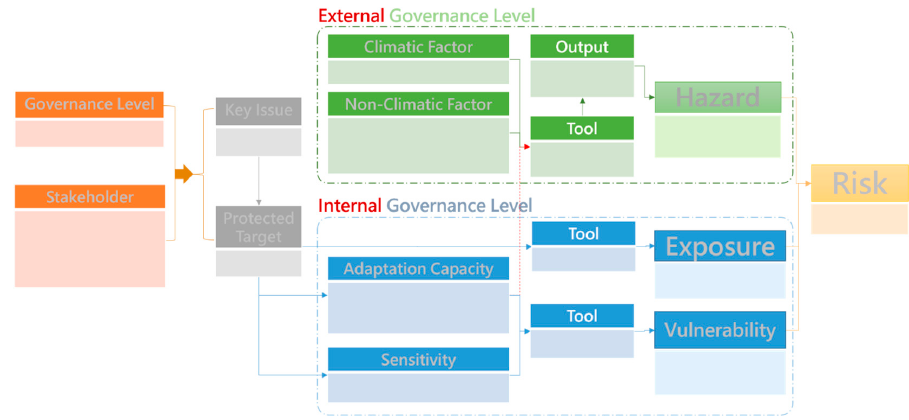
Figure 3. The proposed algorithm of climate risk assessment for presenting tools and indicators.